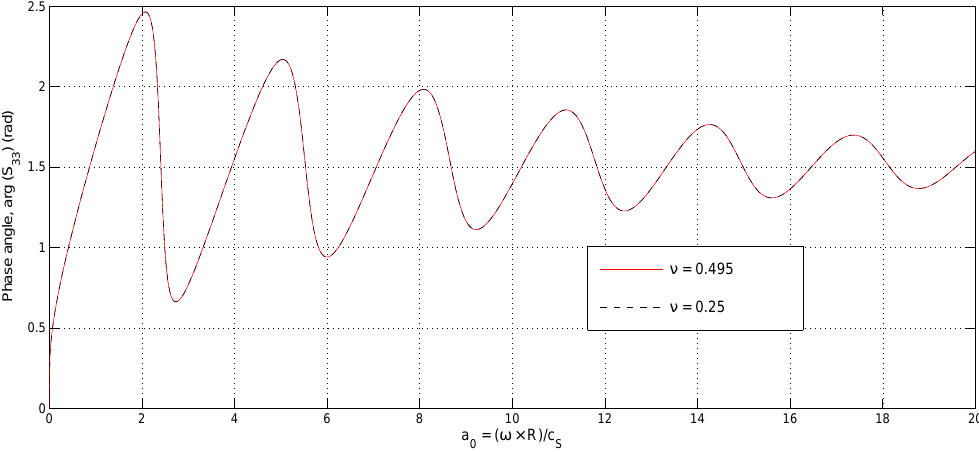
Figure 11. Phase angle of an infinite cylinder due to dynamic vertical load in the axial direction for different values of Poisson’s ratio ν = 0.495 and ν = 0.25 when the loss factor η = 0.1 and E = 9411